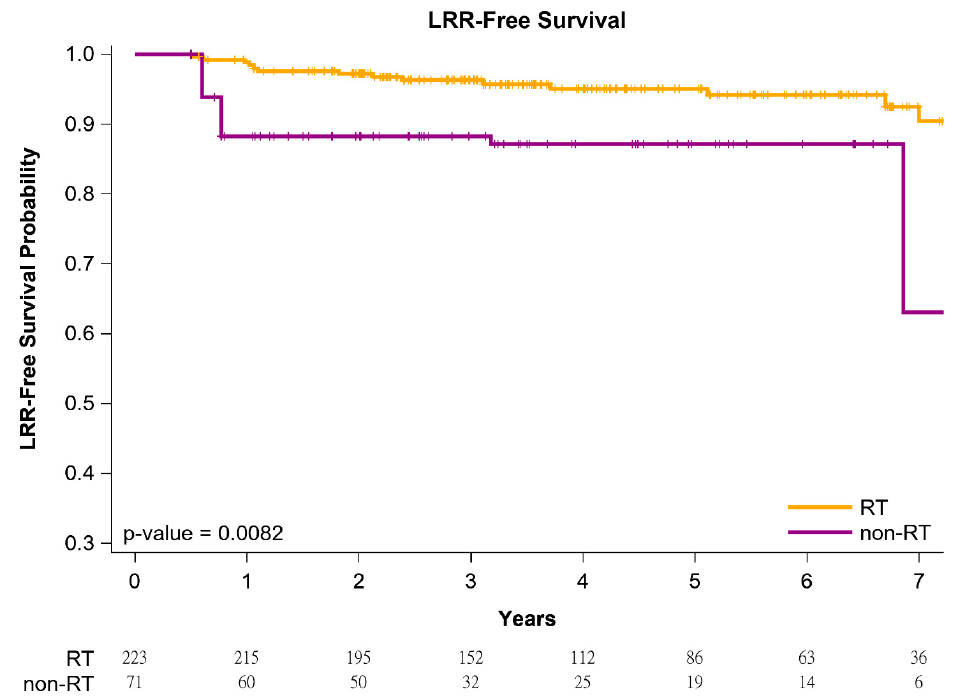
Figure 2. Kaplan–Meier locoregional recurrence-free survival curves of propensity score–weighted population with breast cancer and heart failure with reduced ejection fraction receiving breast conservative surgery.